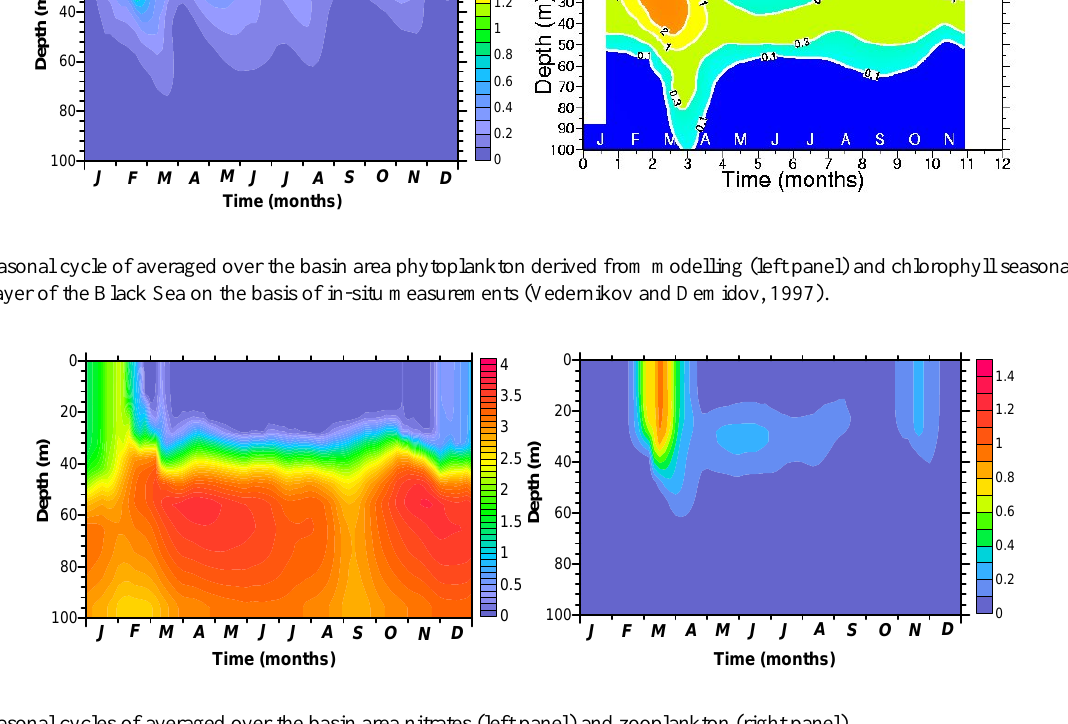
Figure 16 Seasonal cycle of averaged over the basin area phytoplankton derived from modelling (left panel) and chlorophyll seasonal cycle in the upper layer of the Black Sea on the basis of in-situ measurements (Vedernikov and Demidov, 1997)